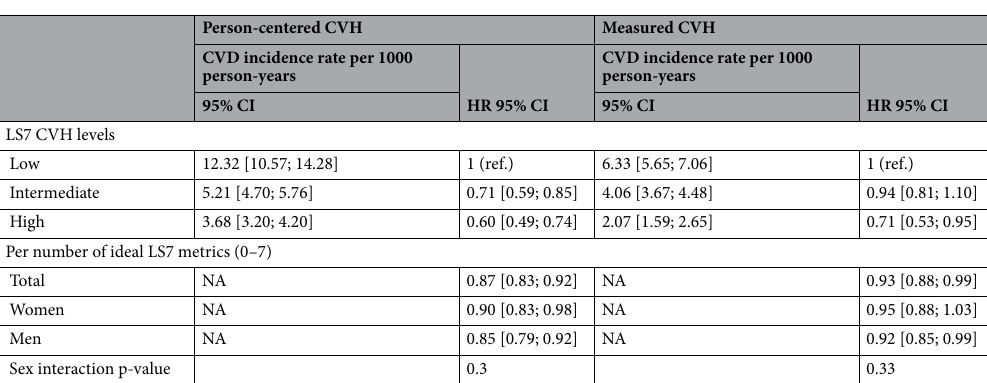
Table 5. Hazard ratios of person-centered and measured Life’s Simple 7 cardiovascular health for incident cardiovascular disease (CVD). LS7 life’s simple 7, CVH cardiovascular health, HR hazard ratio, CVD cardiovascular disease, NA not applicable. Hazard ratios and 95% confidence intervals were estimated by Cox proportional models using age as a timescale, stratified by birth year (5-year intervals), adjusted for baseline sex, cohabitation status, educational attainment, occupational category, alcohol use, and CVD family history. Levels of measured/person-centered LS7 CVH: low (0–2 ideal metrics), intermediate (3–4 ideal metrics), or high (5–7 ideal